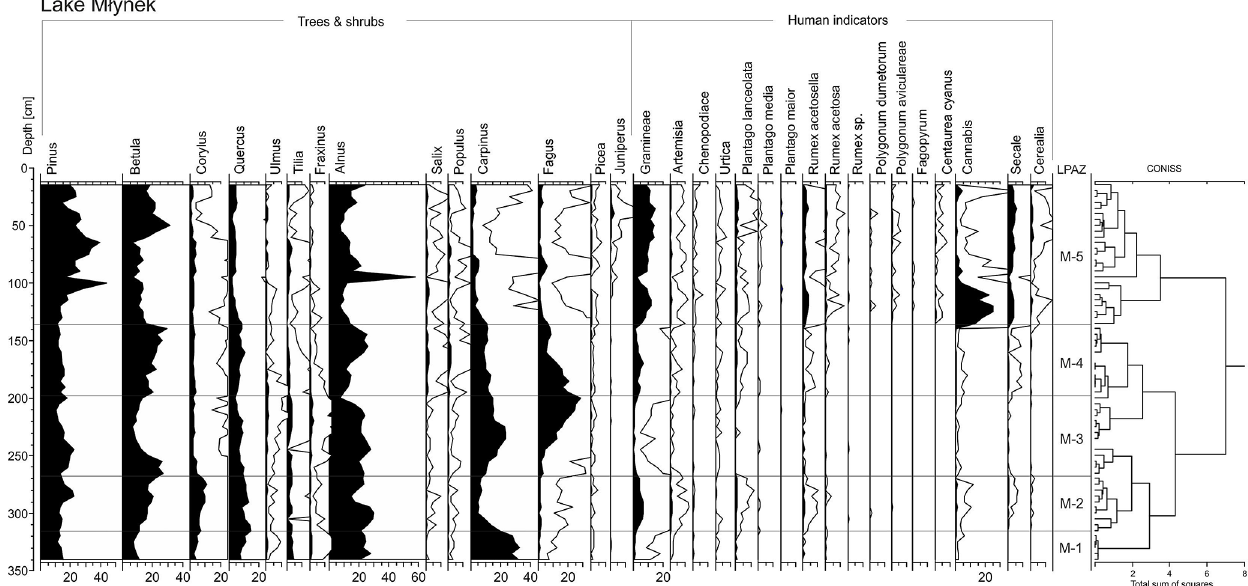
Figure 9. Percentage pollen diagram from core M1 – selected taxa.